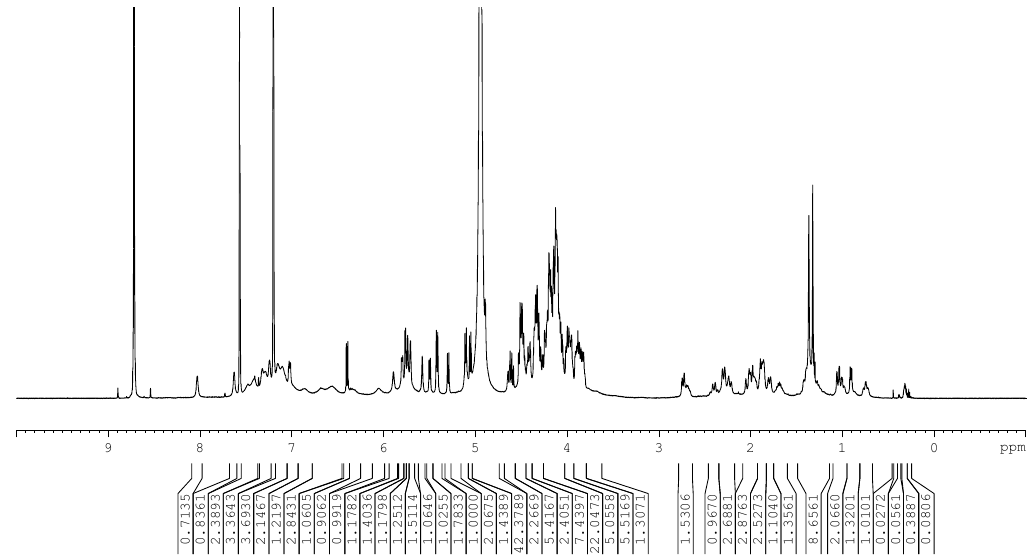
Figure 2. 1 H NMR spectrum of Rebaudioside IX ( 1 ) (500 MHz, 300 K) in pyridine- d 5 . ppm: parts per million.